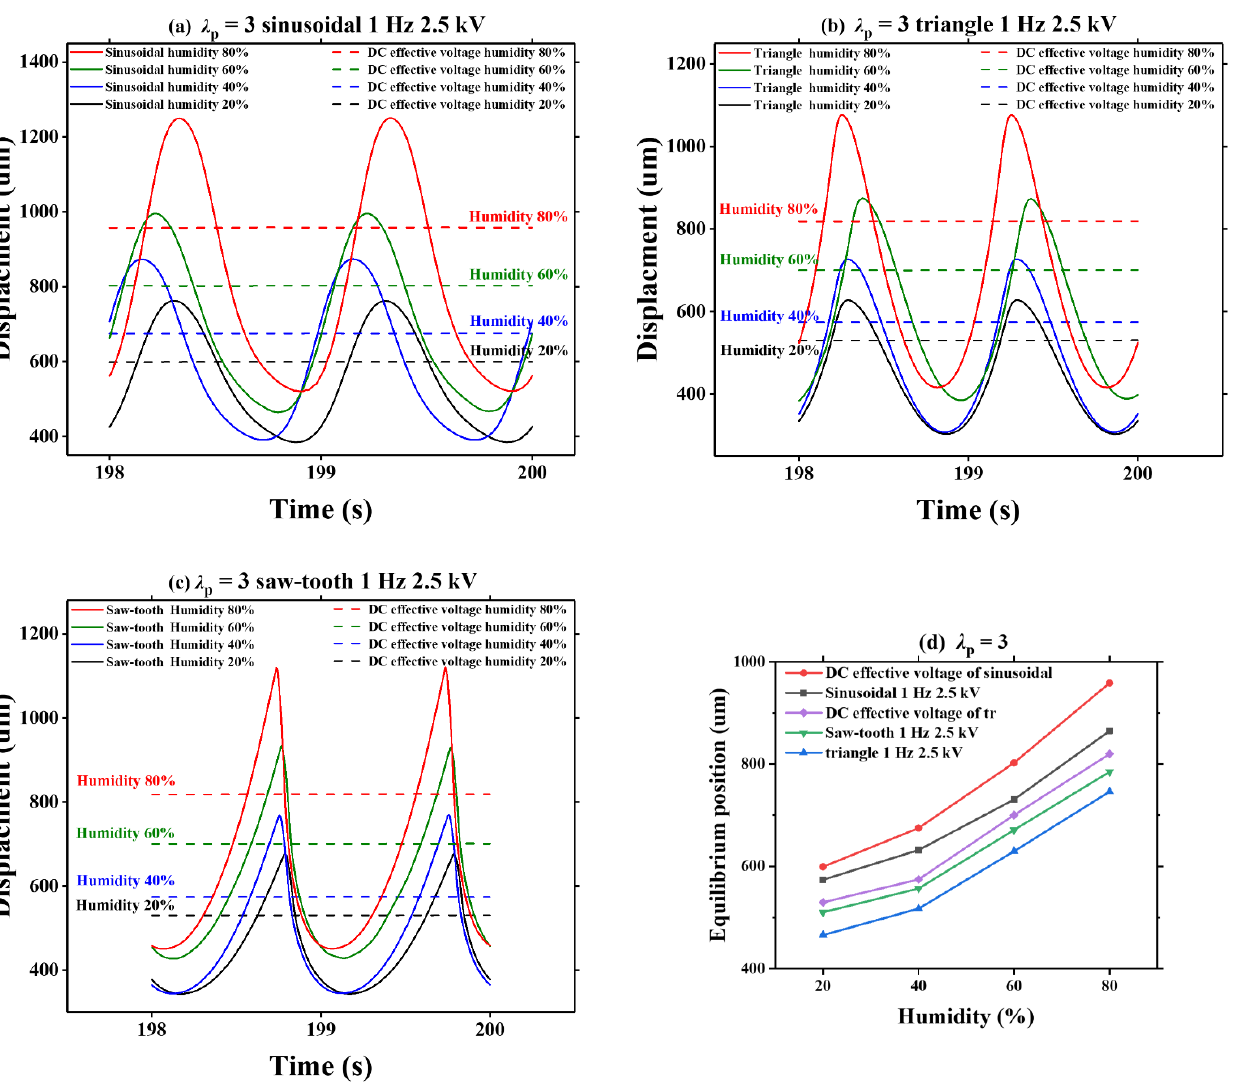
Figure 11. Under different voltage waveforms (sinusoidal, triangle, saw-tooth), experimental results on humidity effects on the viscoelastic creeping of the equilibrium position with the effective DC voltage and the AC voltage: ( a ) pre-stretch ratio of 3 and sinusoidal voltage; ( b ) pre-stretch ratio of 3 and triangle voltage; ( c ) pre-stretch ratio of 3 and saw-tooth voltage; ( d ) the equilibrium position of VHB 4905 under pre-stretch ratio of 3 and different voltage waveforms.